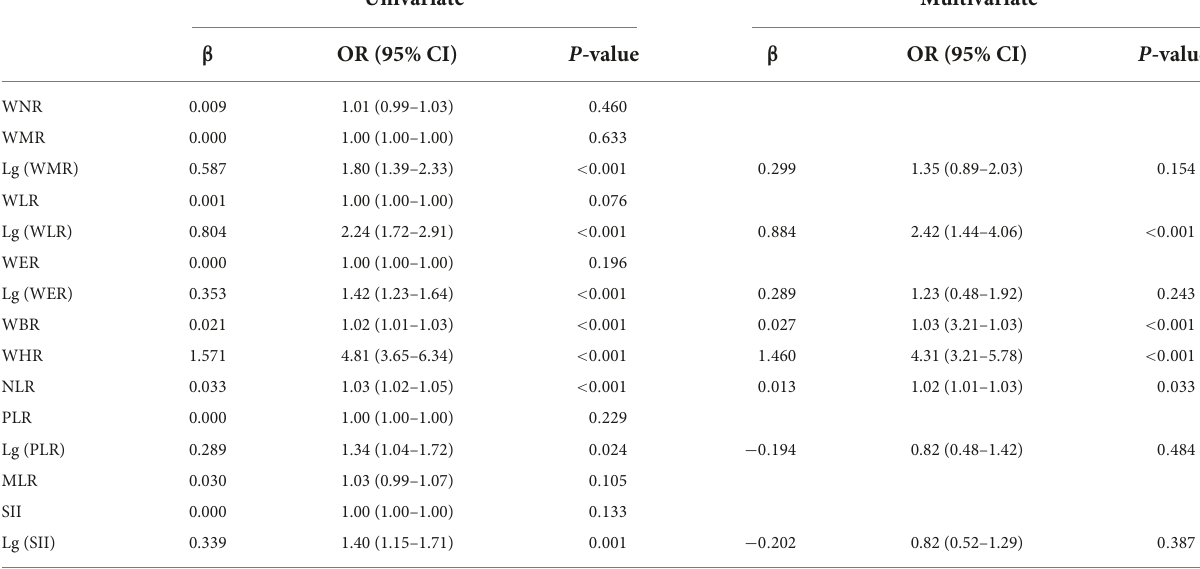
TABLE 2 Logistic regression analysis of WBC-related indicators for AKI.